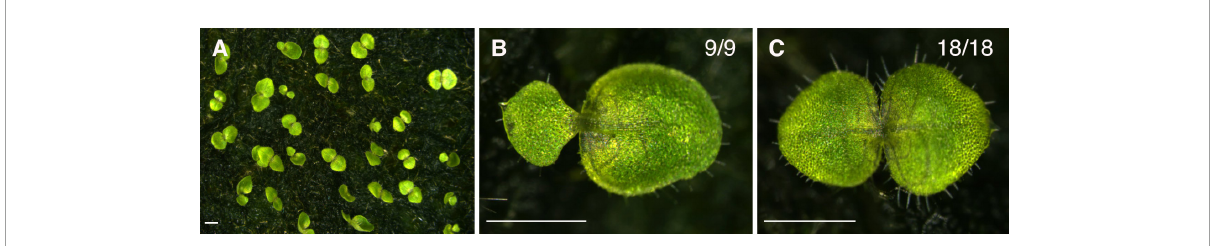
FIGURE3 Application of cytokinin to one of the cotyledons in the isocotylous stage induces both cotyledons to grow as macrocotyledons. (A,C) Individuals treated with lanolin containing cytokinin. All the individuals (18 out of 18) treated with cytokinin had two cotyledons with lateral veins and a wide leaf lamina in the basal part. (B) All the individuals (9 out of 9) treated with lanolin containing DMSO showed clear anisocotyly. Bar = 1 mm.